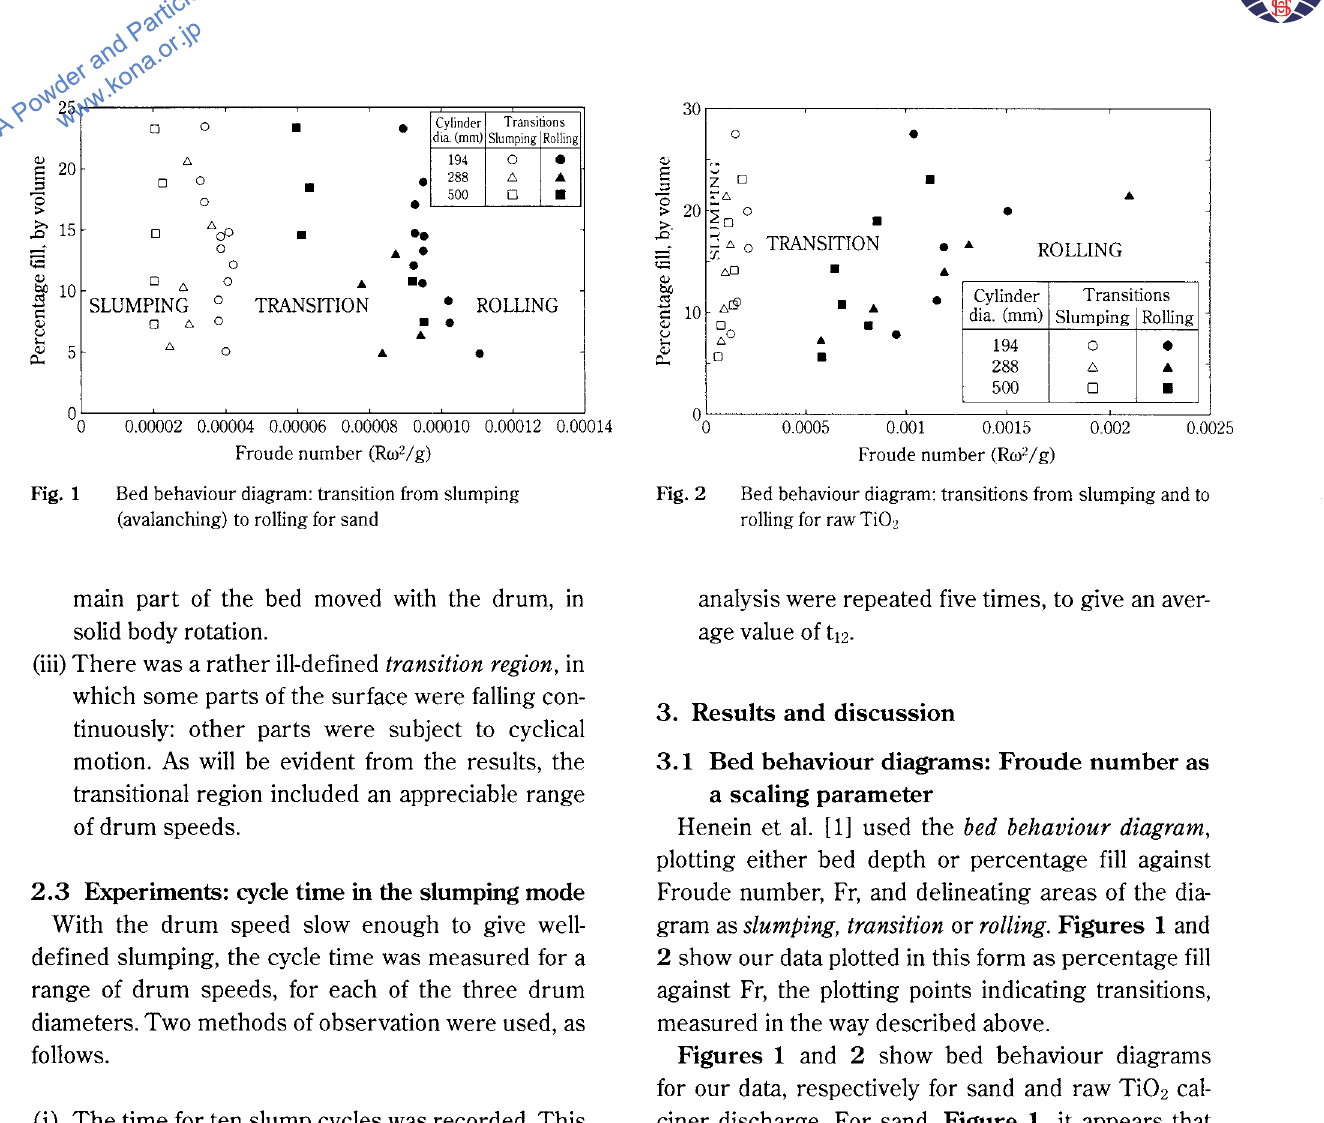
Bed behaviour diagram: transitions from slumping and to rolling for raw Ti0 2